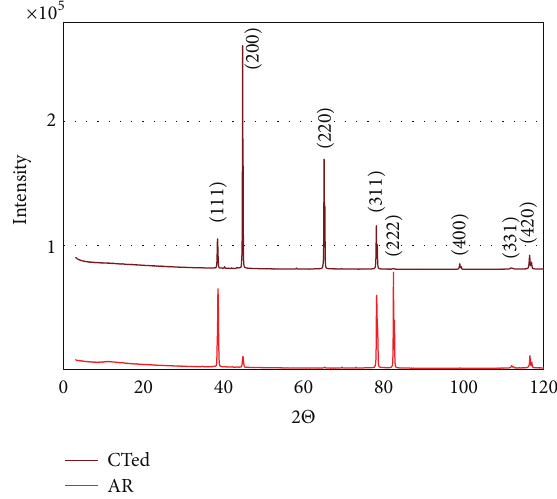
Figure 8: XRD spectrum of an AR and a CTed specimen.